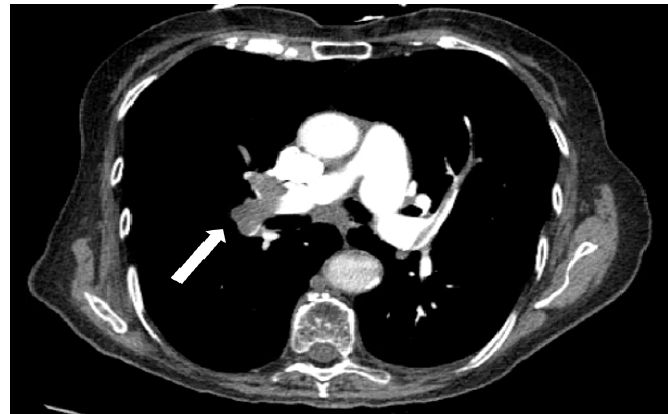
Image 3. Transverse view of the computed tomography pulmonary angiogram. Image redemonstrates the almost-complete occlusion of the right pulmonary artery trunk with the pulmonary embolus